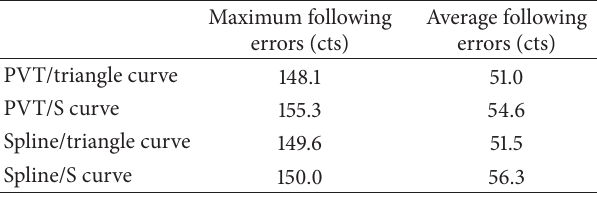
Table 2: The following errors under different modes and